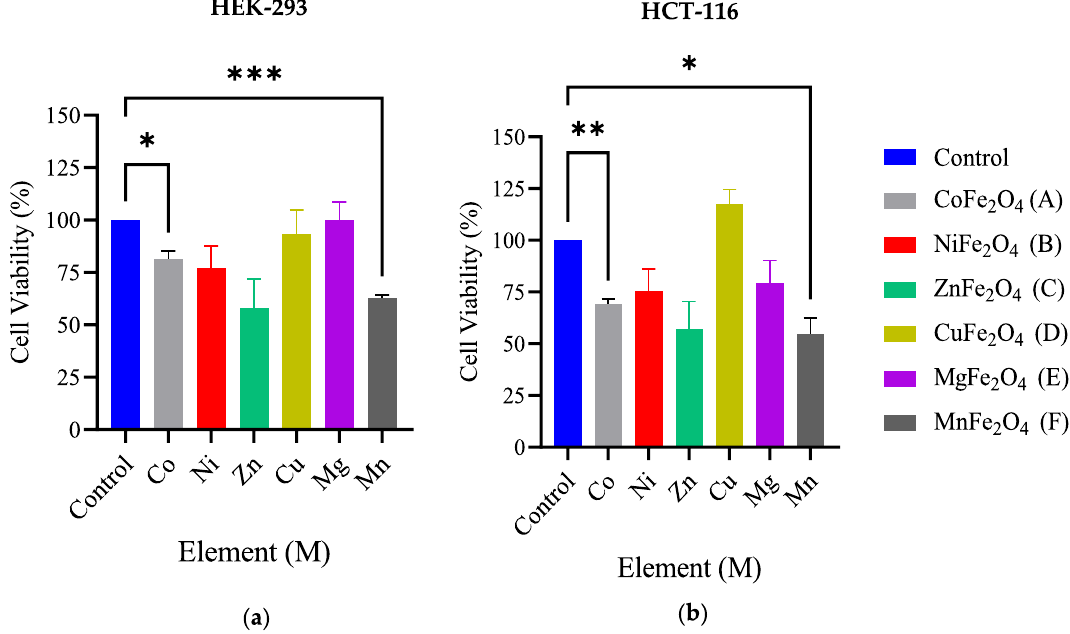
Figure 4. The average cell viability of ( a ) HEK-293 and ( b ) HCT-116 cell lines by MTT assay. Cells were treated with the following core composites MFe 2 O 4 (M = Co, Ni, Mn, Mg, Zn, and Cu) MNPs and treatment concentration was 141.75 µg/ 0.1 ml for 48 h. n = 4 and error bars ± S.E.M. * p < 0.05; ** p < 0.01; *** p < 0.001; versus control.